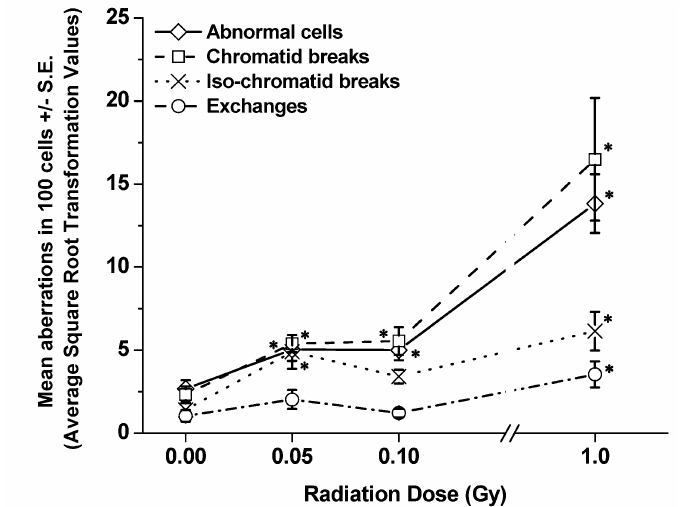
Figure 2. Frequencies of each type of aberration per 100 cells scored (±S.E.) detected in BM cells collected from SCID/J mice at 1 h post-irradiation. Significant differences in the frequencies of each type of CA in BM cells of exposed mice, as compared to the frequencies detected in non-irradiated sham controls are shown at “  ”.